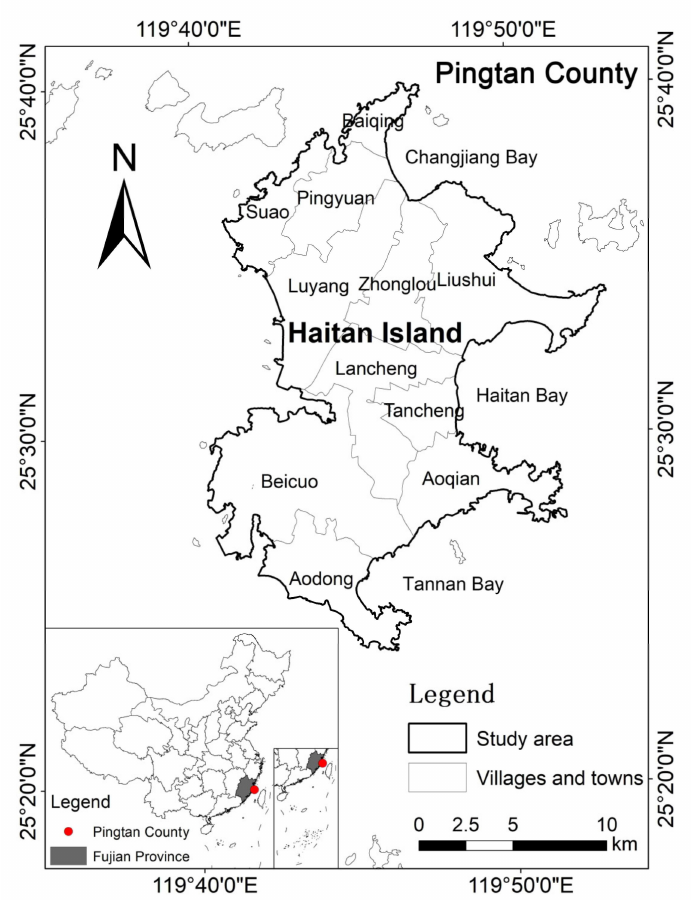
Figure 1. Location of the study site, Haitan Island, within Pingtan County, Fujian,